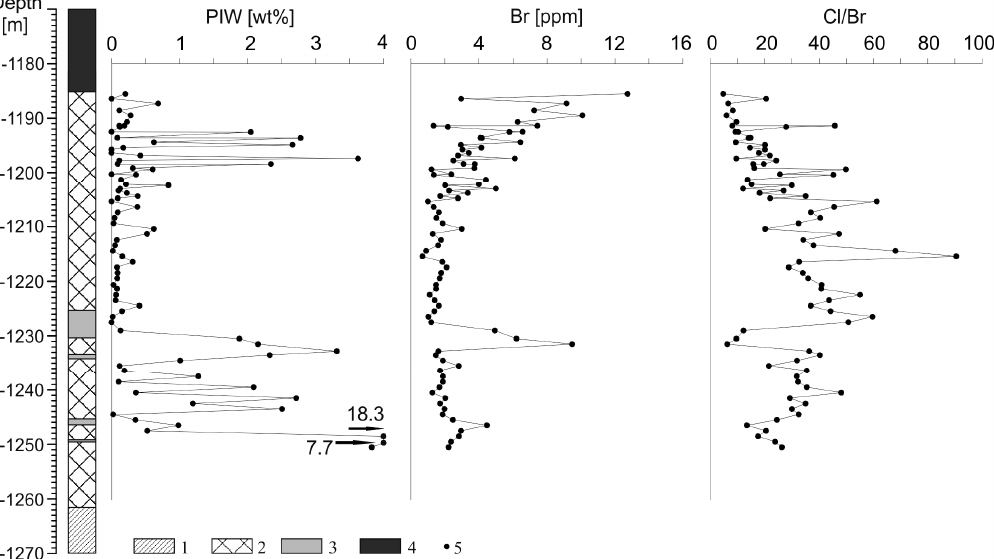
Figure 12. Distribution of parts insoluble in water (PIW), bromide, and chloride-bromide ratio in Lotsberg salt profile. (1) Basal Red Beds sediments, (2) salt rocks, (3) main carbonate intercalations, (4) Ernestina Lake, (5) measurement points